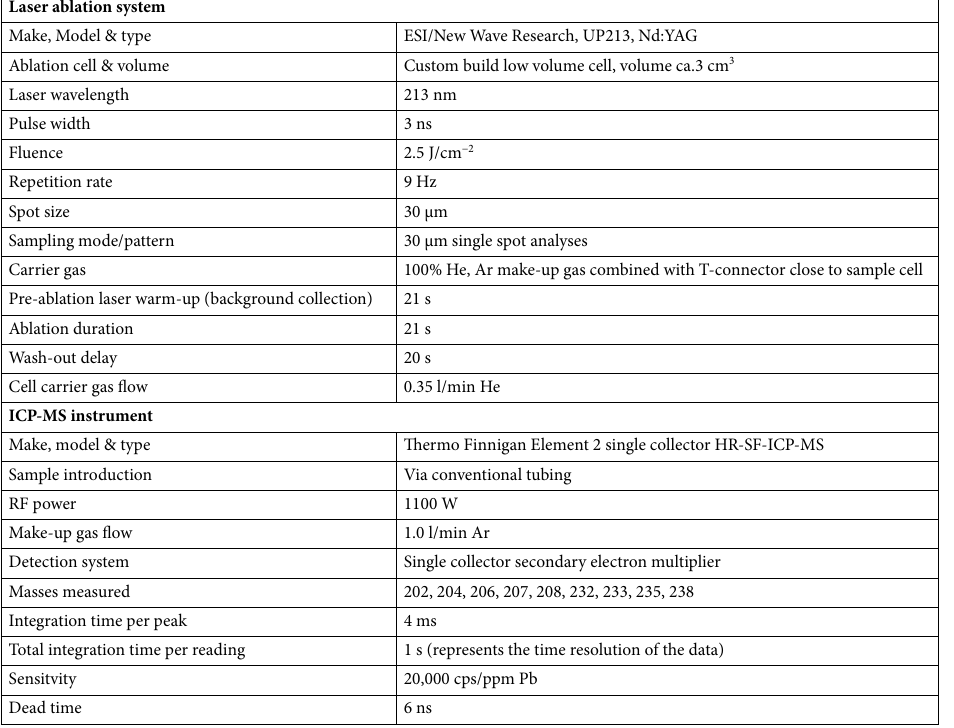
Table 3. Instrument specifications for the LA-SF-ICP-MS operating